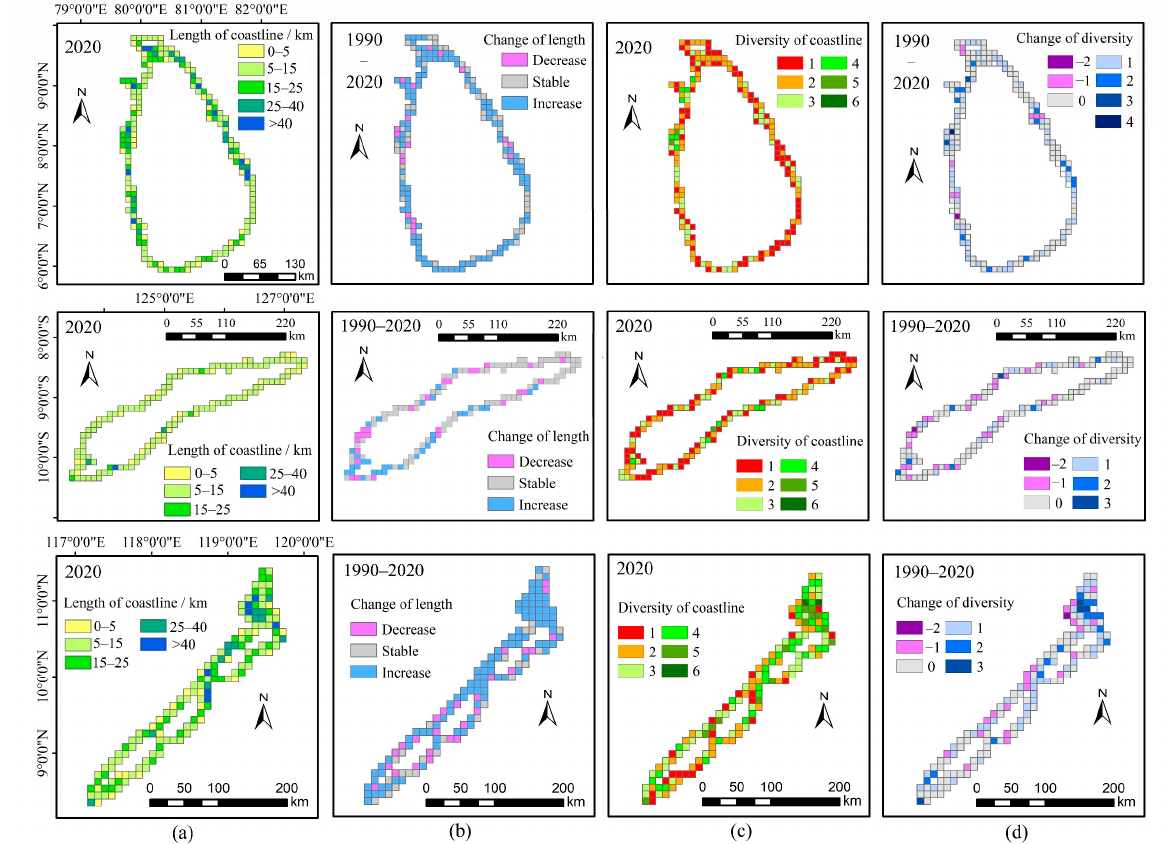
Figure 11. Length and diversity of coastline for three islands. ( a ) Spatial distributions of the coastline length in 2020. ( b ) Map showing the increase and decrease in coastline length from 1990 to 2020, where stable stands for changes in the range of − 0.1 km to 0.1 km, decrease stands for changes of less than − 0.1 km, and increase stands for changes of over 0.1 km. ( c ) Spatial distributions of coastline diversity in 2020. ( d ) Change in coastline diversity from 1990 to 2020.